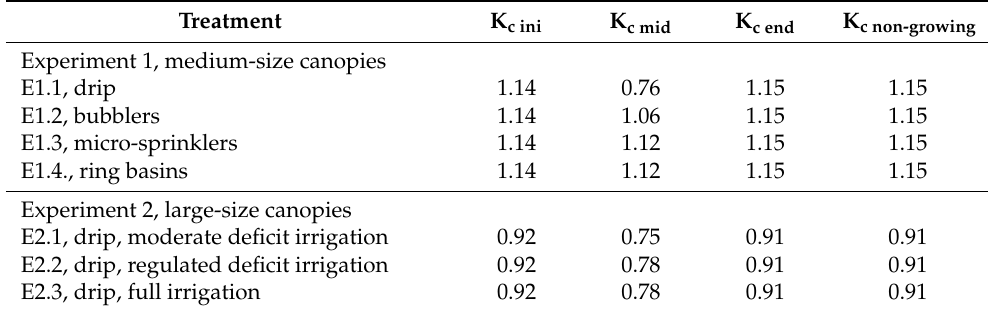
Table 13. Single crop coefficients of a clementine orchard with different canopy sizes and various irrigation methods.